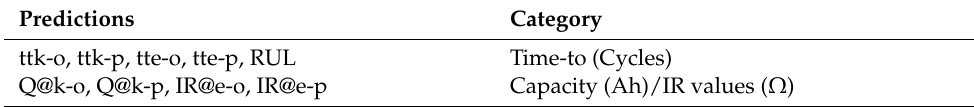
Table 1. Summary of the targets predicted by the one-cycle CNN-based model [20] (also [22]).